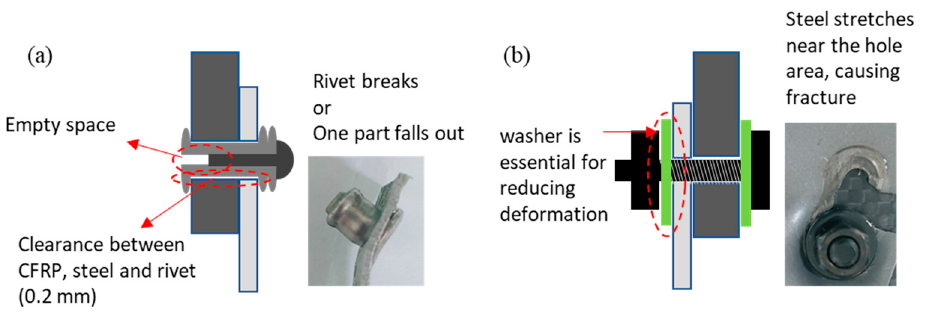
Figure 7. Deformation of the washer and adhesive joint: ( a ) riveting and ( b ) bolting.